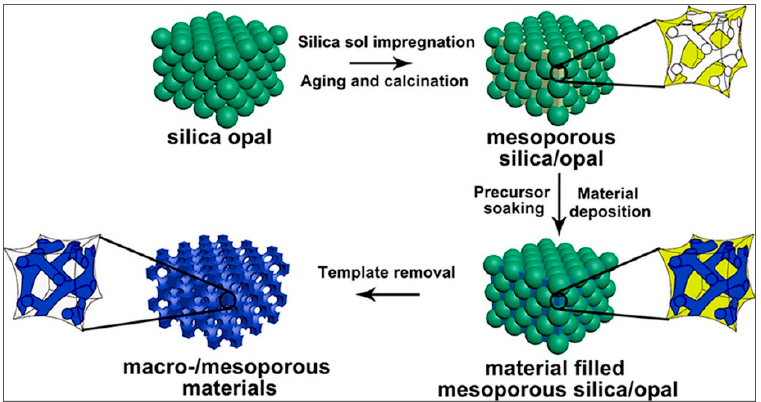
Figure 1. Schematic representation of 3D macro / mesoporous materials preparation reproduced with permission from [34], Chemistry of Materials, 2018.